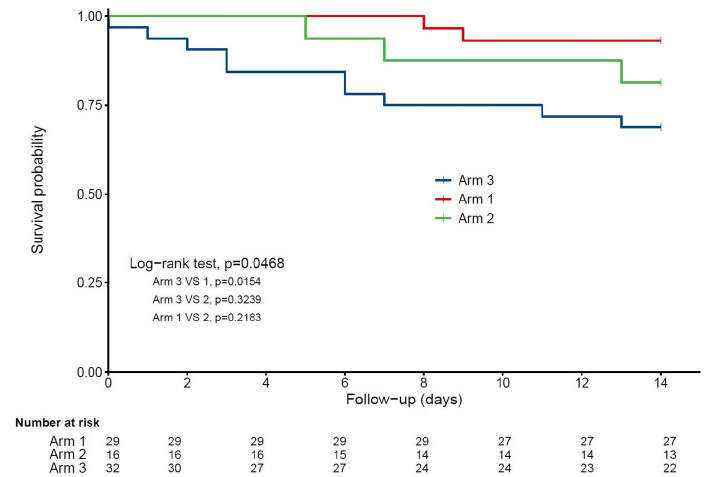
Figure 2. Kaplan–Meier estimates of the cumulative probability of COVID-19 participants’ survival according to vitamin D interventions ( n = 77). Arm 1: regular vitamin D supplementation; Arm 2: vitamin D supplementation initiated after COVID-19 diagnosis; Arm 3: no vitamin D supplementation.